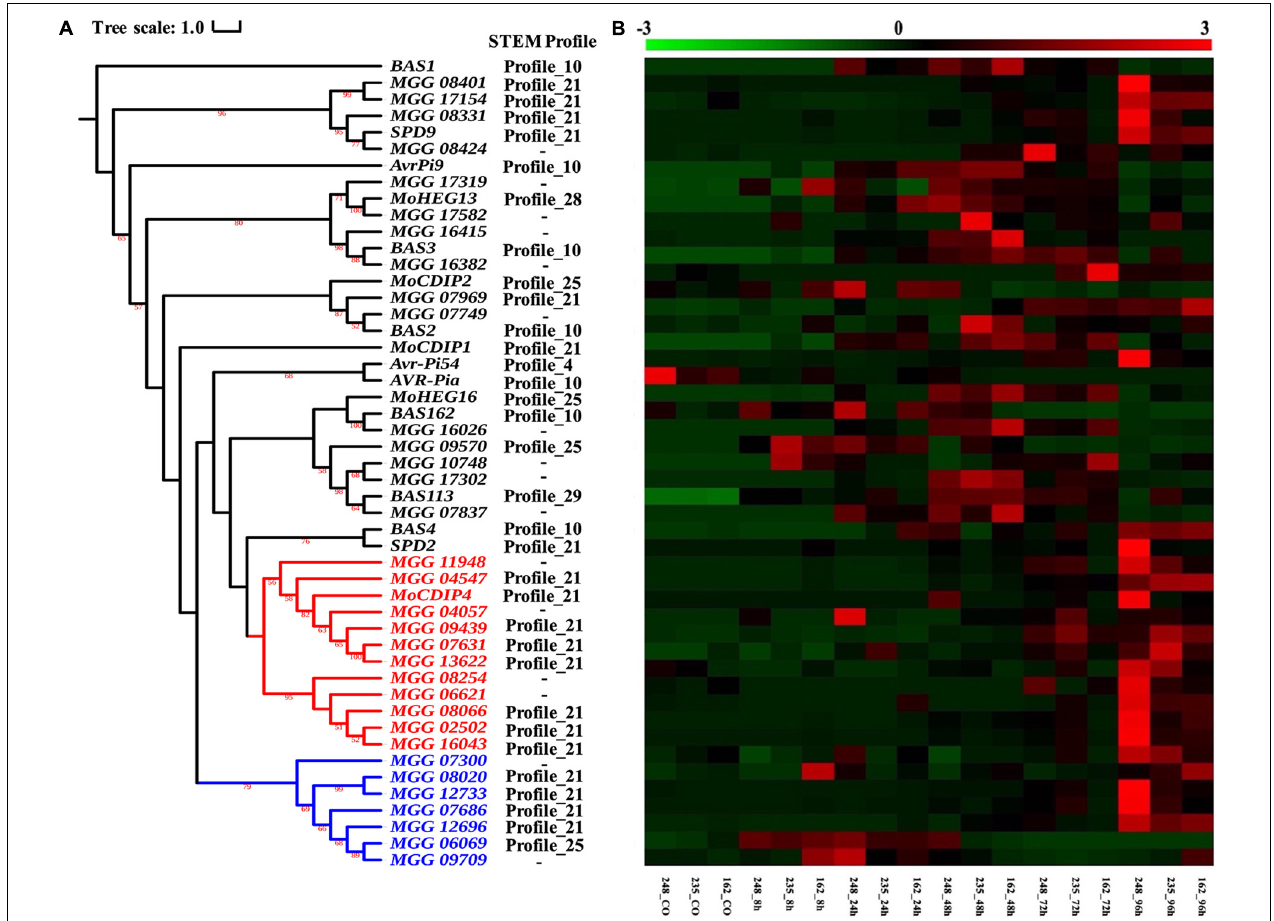
FIGURE 8 | Analysis of verified and potential effectors. (A) Phylogenetic tree of 45 verified effectors in M. oryzae and their homology genes. The maximum likelihood tree with 1,000 bootstraps was displayed (values displayed per branch). Red and blue branches represent the MoCDIP4 effector and its homolog genes. (B) Expression pattern of verified and potential effectors which followed the topologic order of phylogeny